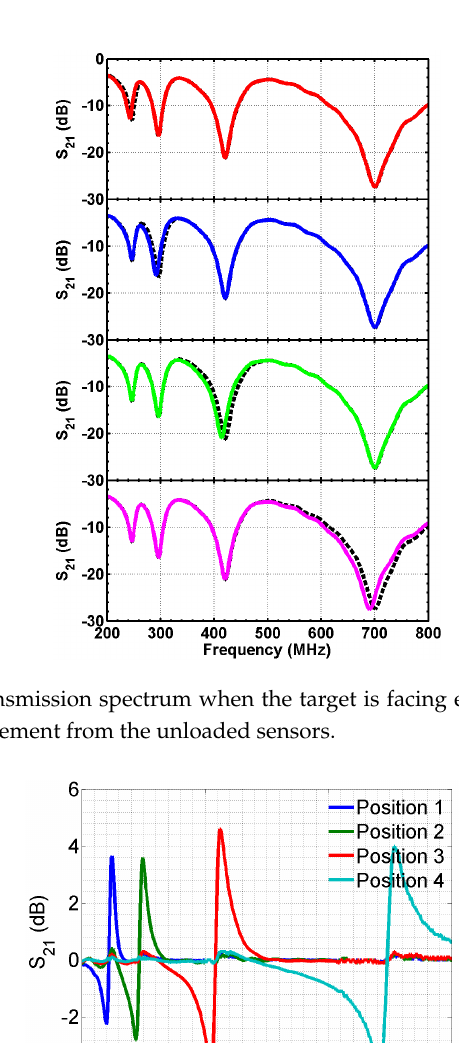
Figure 9. Fabricated capacitive sensor array on a microstrip line with connected surface mount inductors.